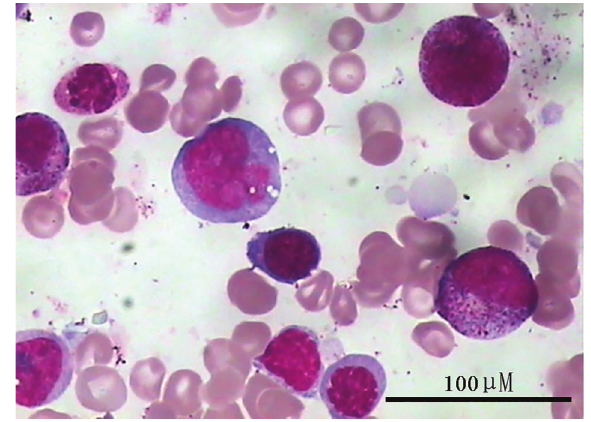
Figure 1. Hyperplasia of bone marrow, decreased granulocyte ratio, increased erythroid proportion, containing 12% unclassi fi ed cells. Bar: 100 m m.